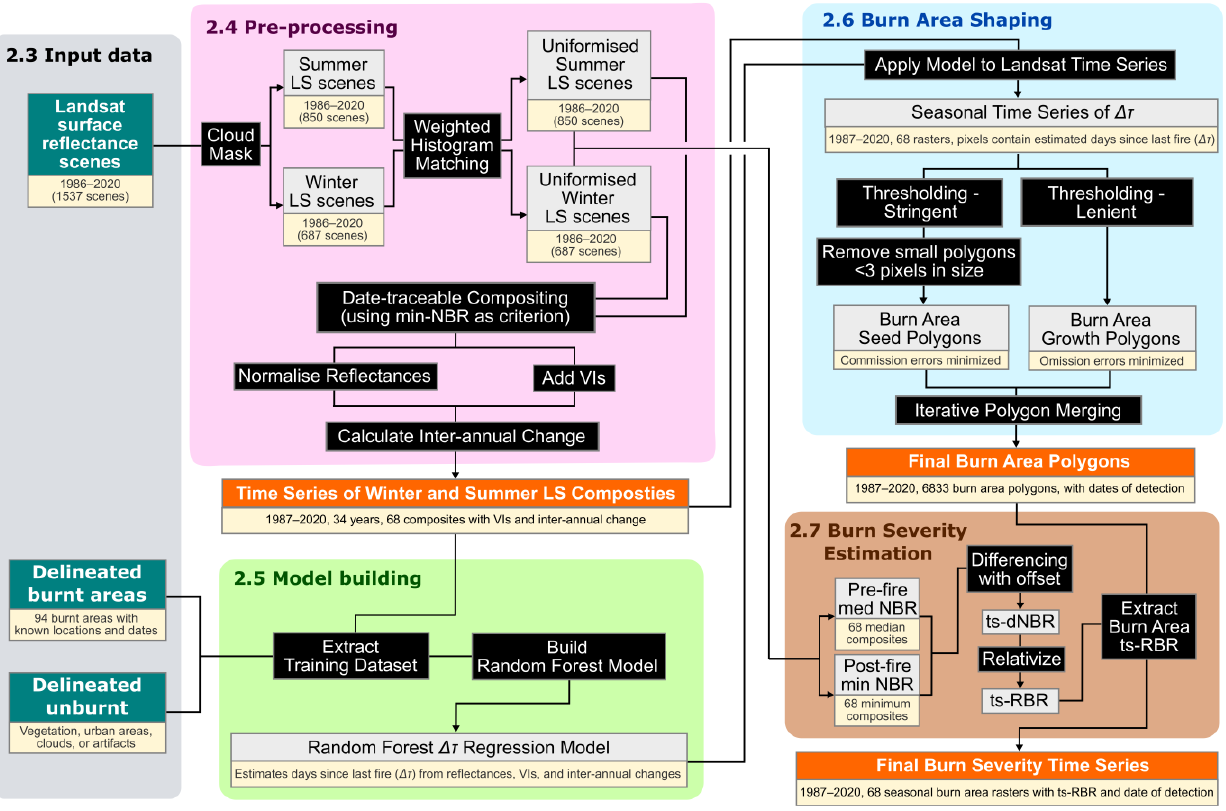
Figure 2. Flow chart visualizing the LTS fire pipeline. The green boxes indicate input datasets; black boxes represent actions taken; grey boxes signify intermediate products; and orange boxes show end products. Numbering corresponds to the relevant section in the methods.